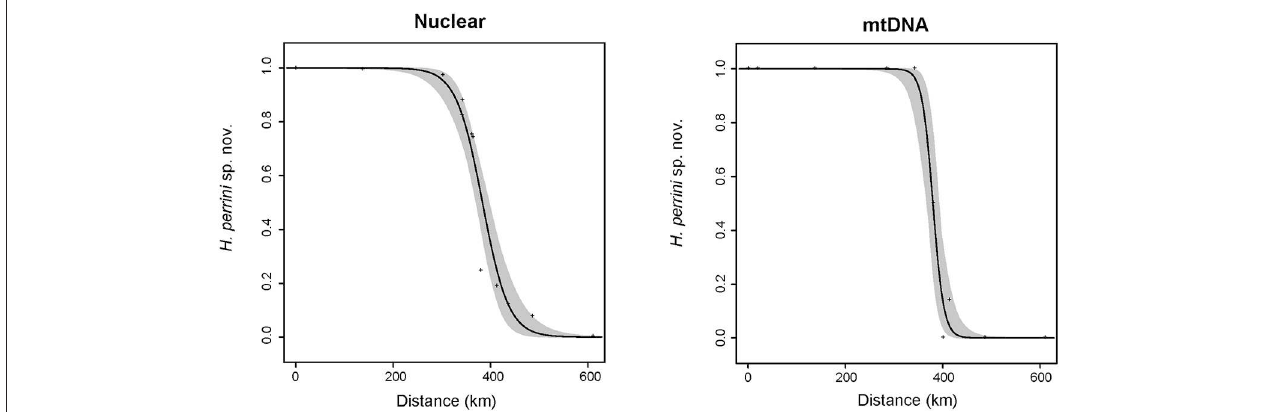
FIGURE 5 | Geographic clines fitted to nuclear hybrid index data (STRUCTURE admixture coefficient, left panel ) and mitochondrial frequency data (right panel) along the H. perrini sp. nov./ H. intermedia s. s. transect. The best selected models featured only two parameters (width and center), while parental frequencies could be set to 0 and 1. Nuclear cline: width w 96km and center c 378km; mitochondrial cline: w 40km and c = = = =